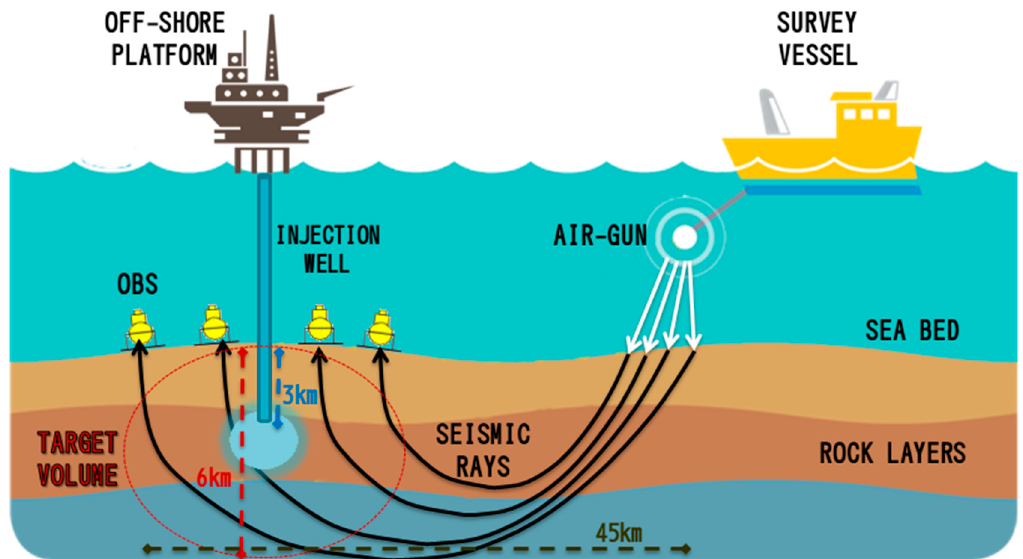
Figure 1. Scheme of offshore active survey around the injection well. The area bounded by the red curve represents the survey volume located at about 6 km.